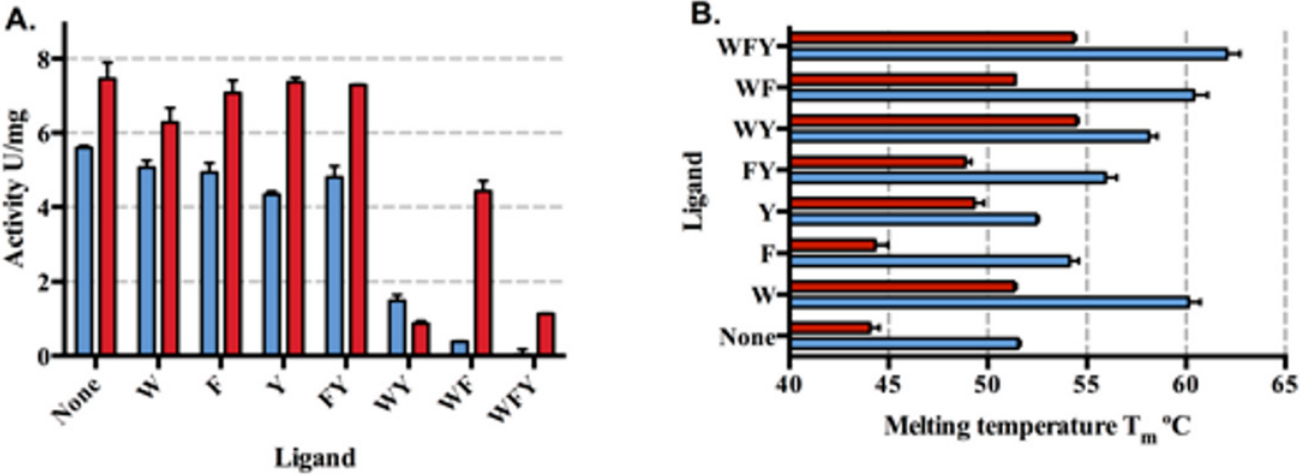
Fig 7. Inhibition of Mtu DAH7PS N175A by aromatic amino acids compared to wild type enzyme. (A) Remaining activity of Mtu DAH7PS (blue) and Mtu DAH7PS N175A (red) in the presence of various single, binary and ternary combinations of aromatic L -amino acids. Assays conducted in the presence of 150 μ M E4P and PEP. Error bars depict the standard deviation of triplicate measurements. (B) The effect of single, binary and ternary combinations of aromatic L -amino acids on the thermal stability of Mtu DAH7PS (blue) and Mtu DAH7PS N175A (red). The aromatic amino acids are represented by one letter code. Each letter also represents 200 μ M of the corresponding aromatic L -amino acids.